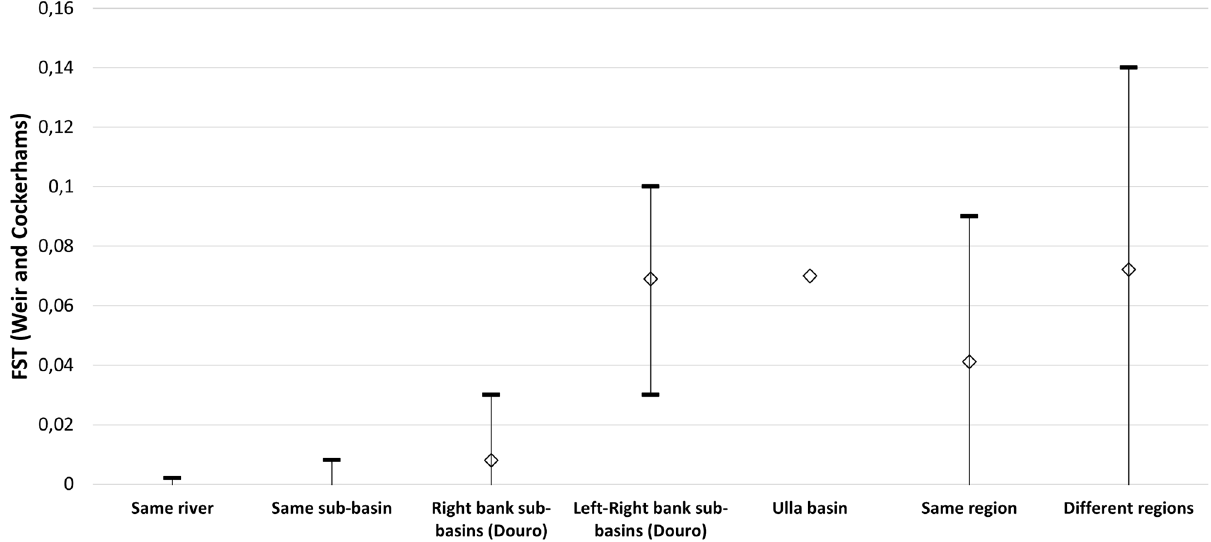
Figure 3. Range of F ST values (Weir and Cockerham’s estimator) between pairs of locations for each hydrologic unit category, considering “region” as Atlantic, Cantabrian and Douro basins.